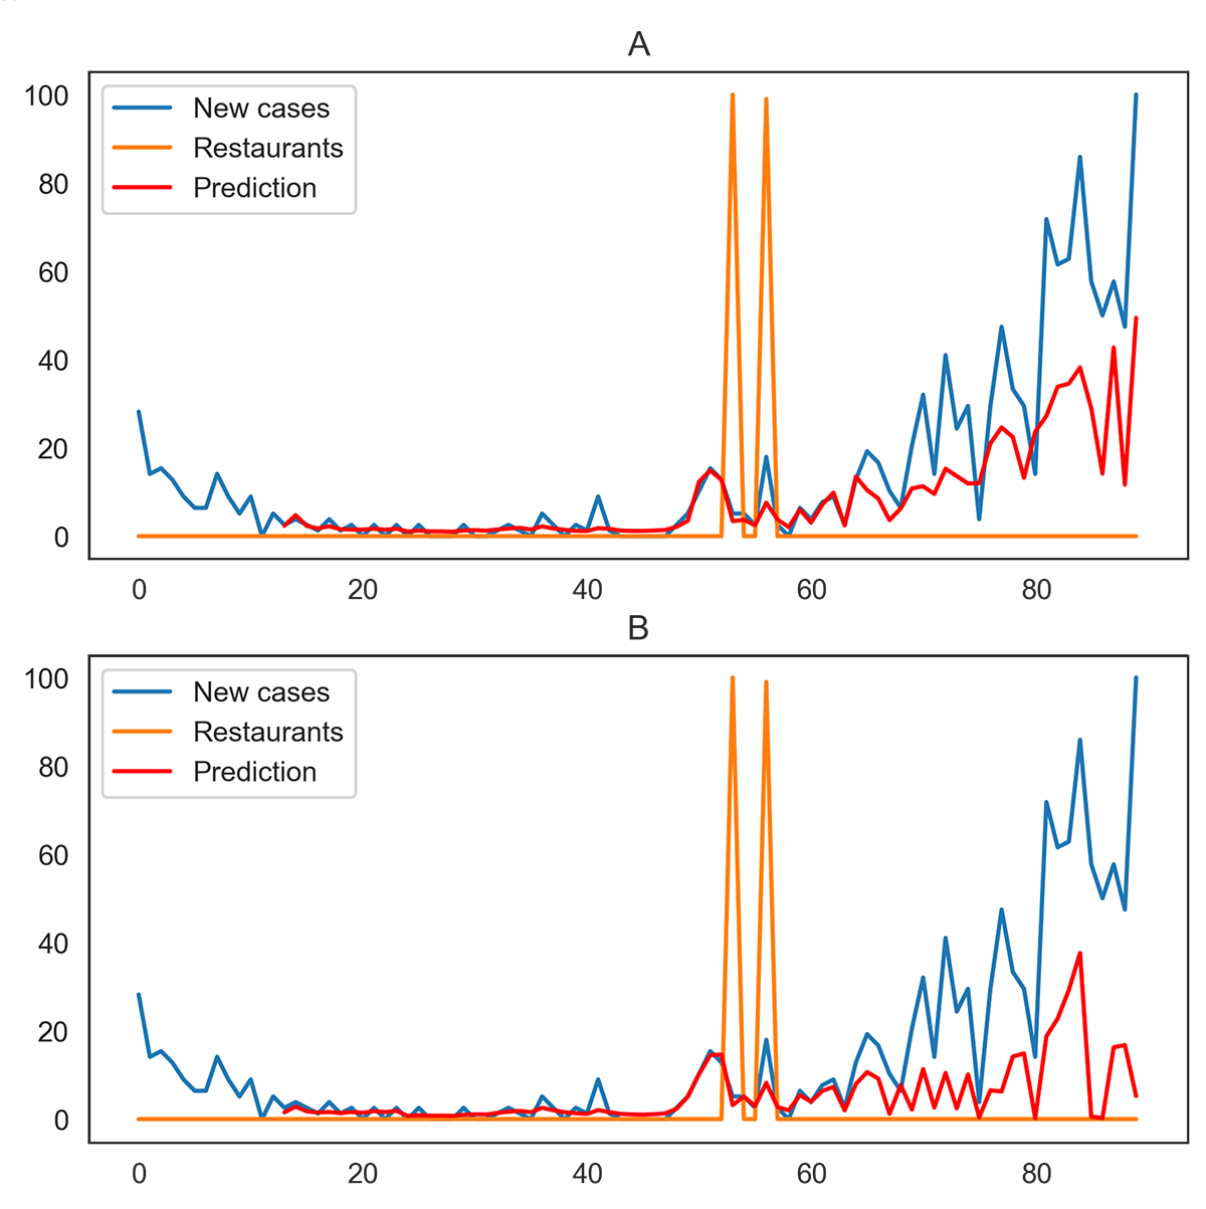
Figure 6. Prediction values for daily new cases of COVID-19 without (A) and with (B) restaurant search trends for Montana from April 9 to July